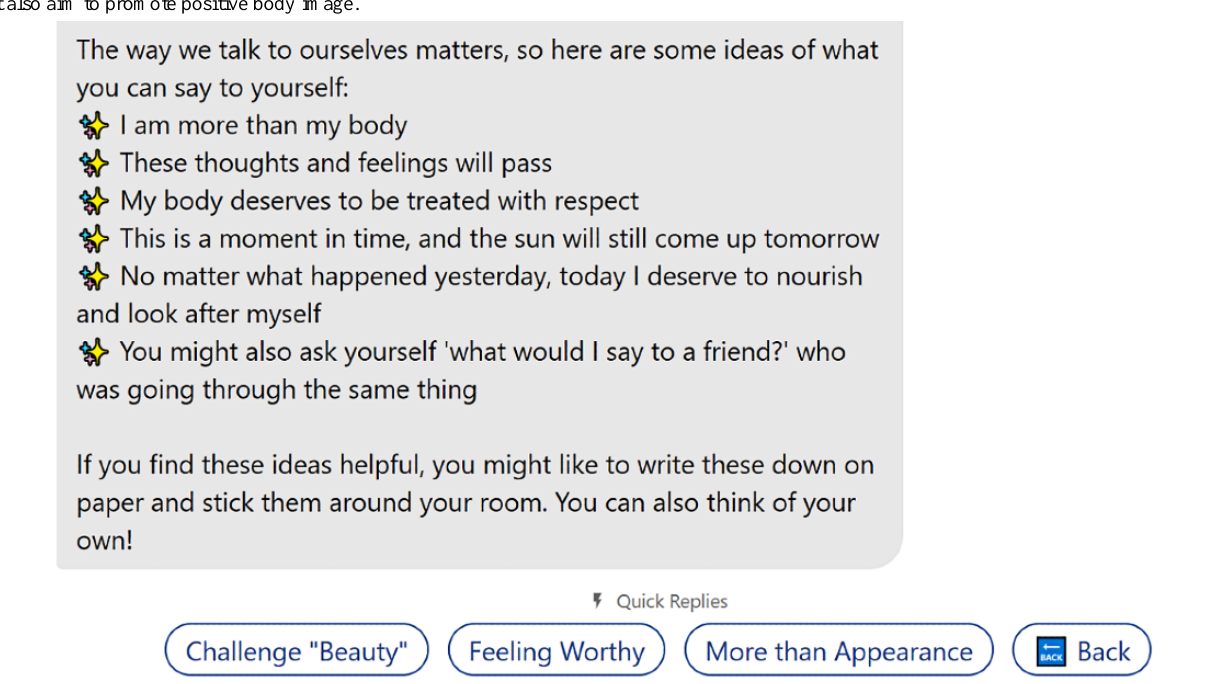
Figure 2. An example of one of KIT’s coping skills conversations, “Positive Self-Talk,” with prompts to continue the conversation with other skills that also aim to promote positive body image.